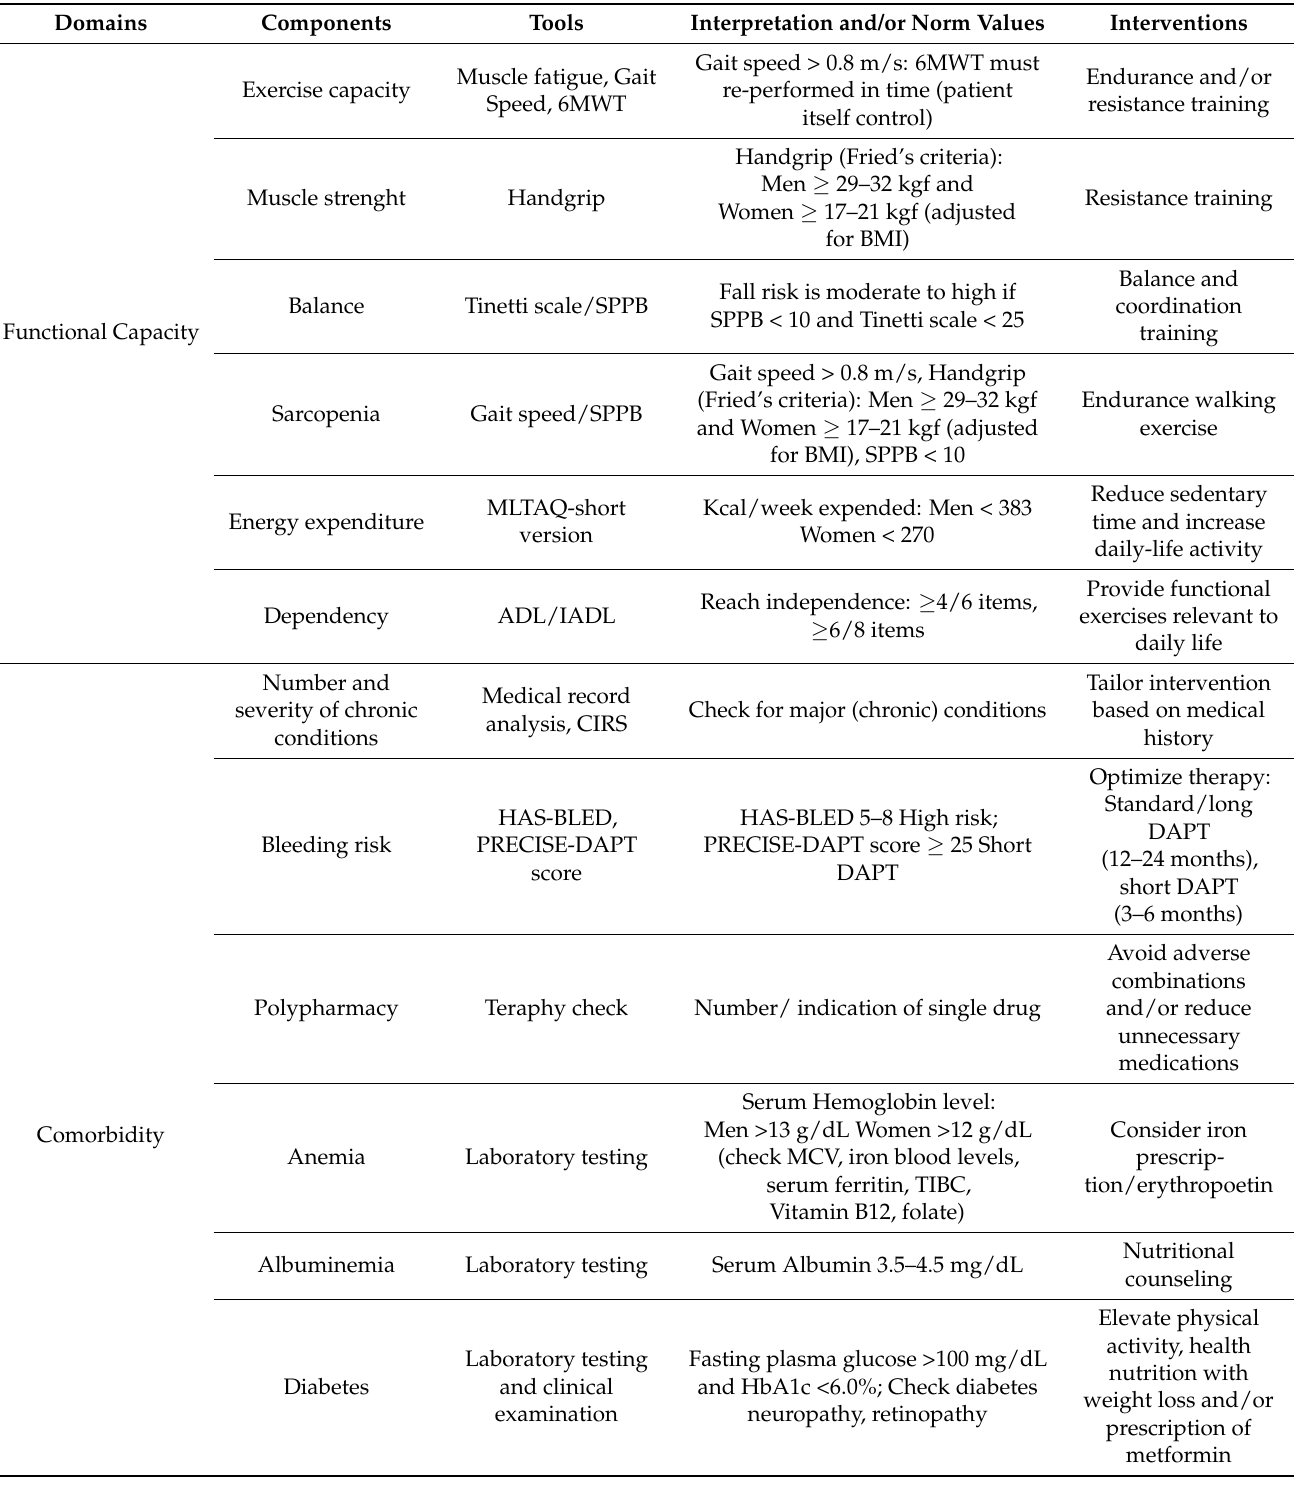
Table 1. Principal domains, components and tools for frailty patients with cardiovascular disease enrolled to Cardiac Rehabilitation